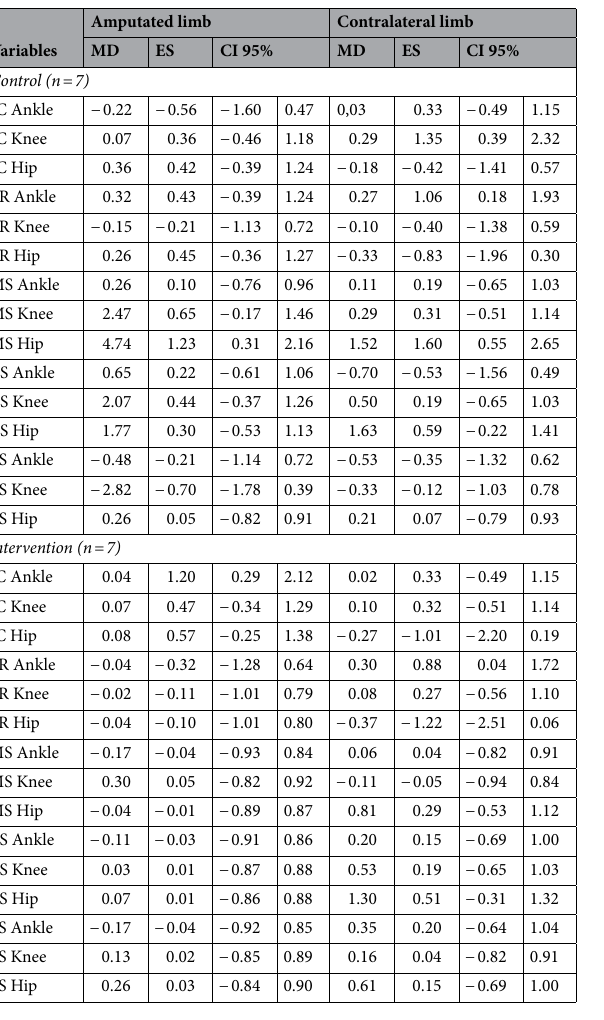
Table 6. Analysis of the magnitude of the intervention effects on ankle, knee, and hip joint moments (Nm/ Kg) in the sagittal plane during stance phase. MD: Mean difference; ES: Effect size; 95% CI: 95% confidence interval. Phases of the gait cycle are abbreviated as: IC (0–2% GC)—Initial contact; LR (0–10% GC)—Loading response; MS (10–30% GC) – Mid stance; TS (30–50% GC) – Terminal stance; PS (50–60% GC)—Prerswing; Dorsiflexion ( +) and plantar flexion of the ankle (-); Flexion ( +) and extension of the knee (-); Flexion ( +) and extension (-) of the